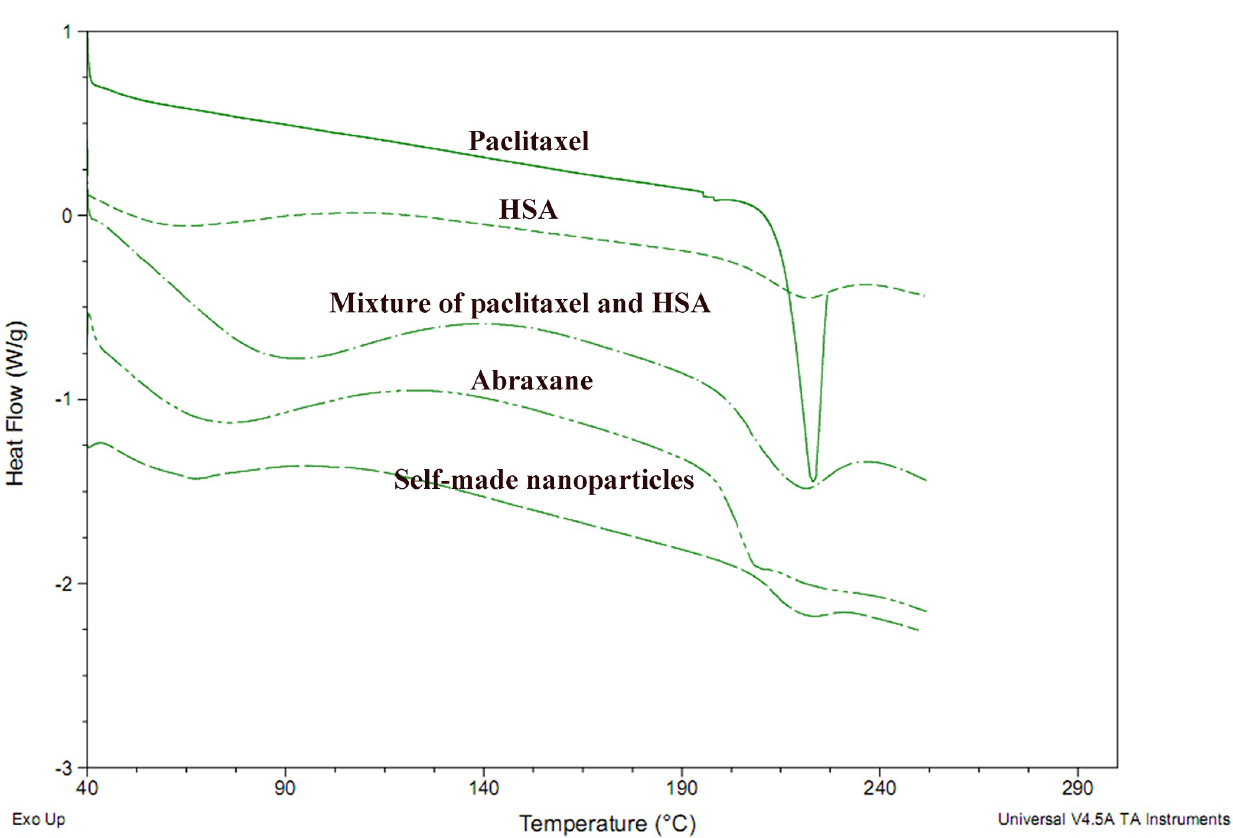
Fig 5. DSC thermograms of paclitaxel, HSA, physical mixtures of paclitaxel and HSA, Abraxane, and self-made nanoparticles.